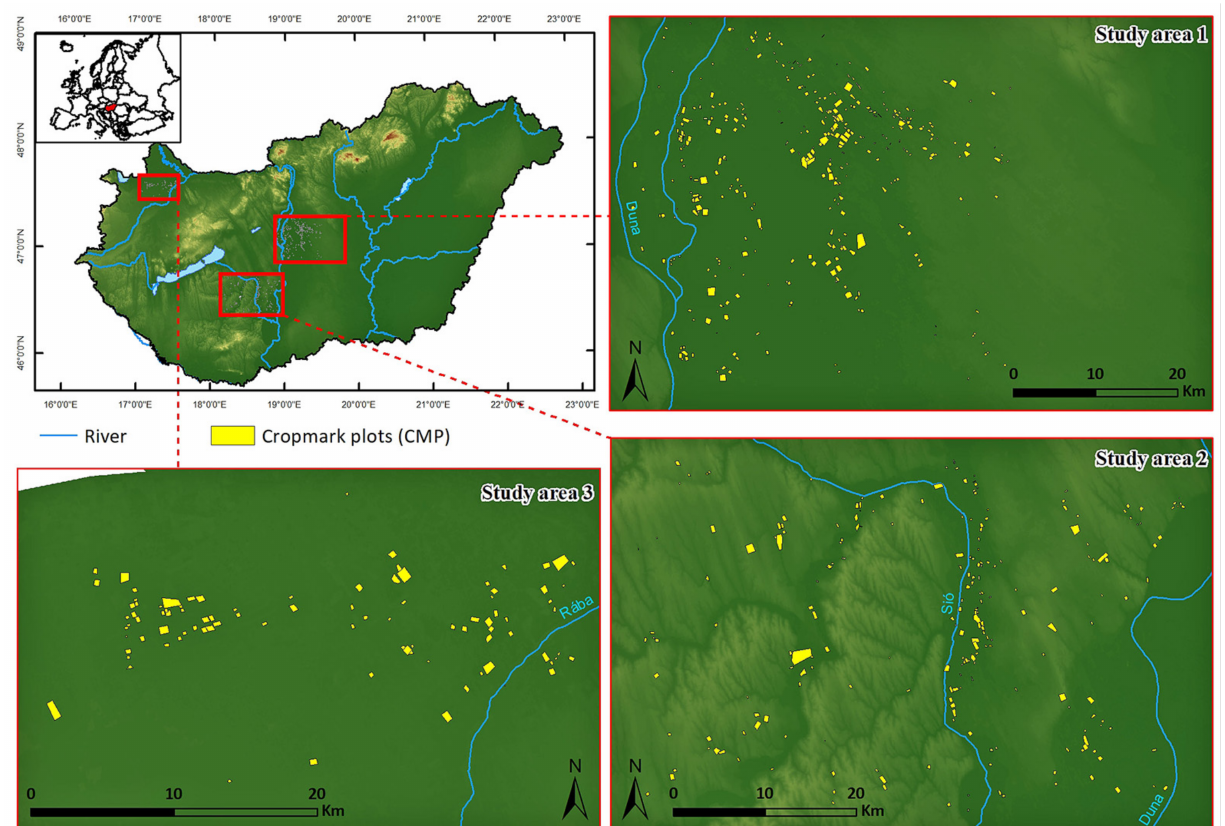
Figure 3. Location of the study areas. Cropmark plots (CMPs) are displayed in